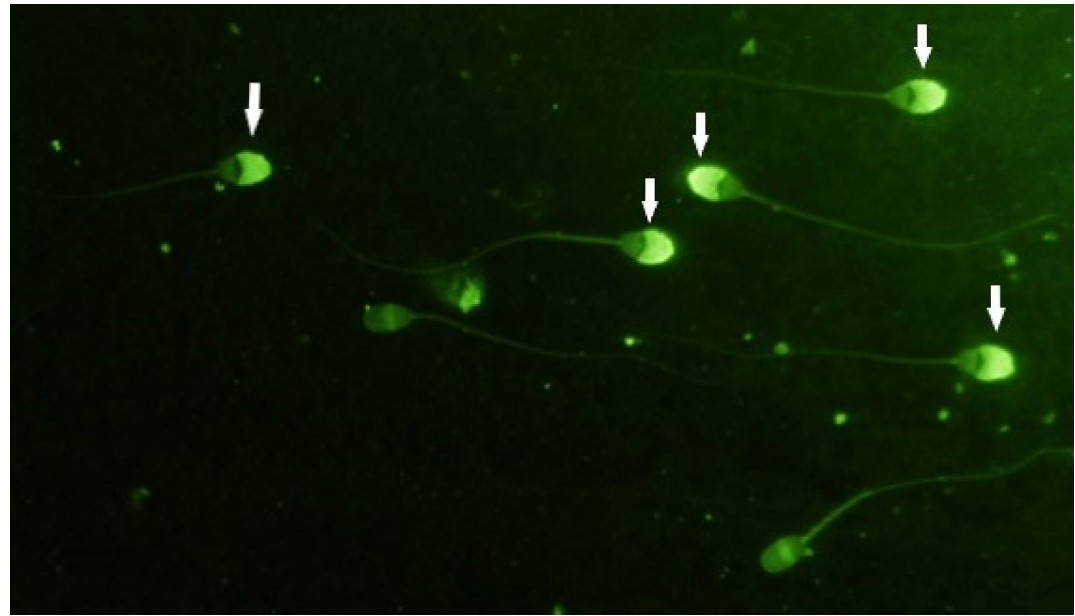
Figure 1. Example of spermatozoa as evaluated for acrosome integrity. Sperm that have completely absorbed the fluorescent green color in the head area are considered as sperm with healthy acrosome (Indicated by arrows) and sperm that did not absorb the fluorescent color or absorbed the color in limited areas are considered as acrosomes with damaged